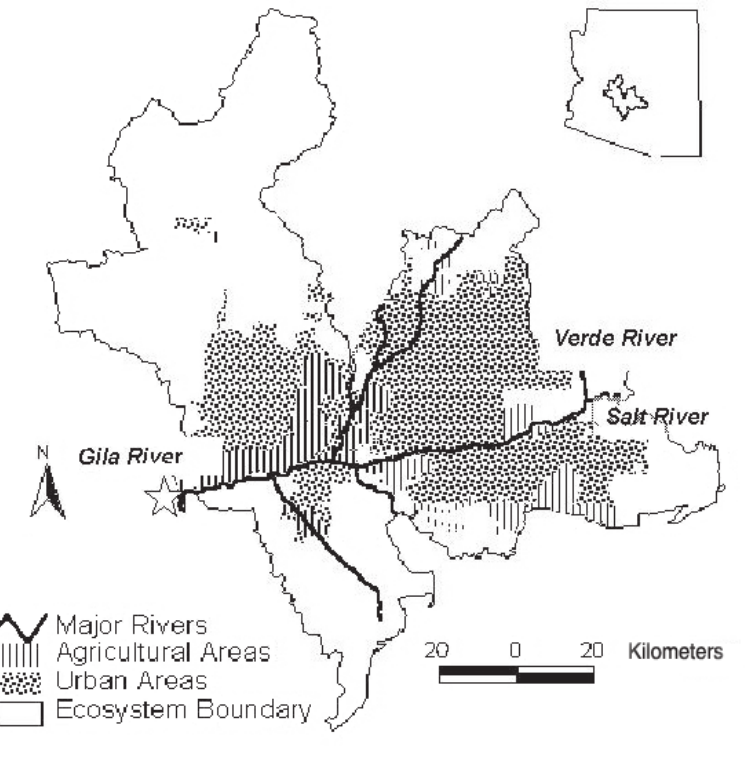
FIGURE 1. Map of the CAP-LTER watershed. The data in Fig. 2 was collected at the Gila River outflow, marked with a star (